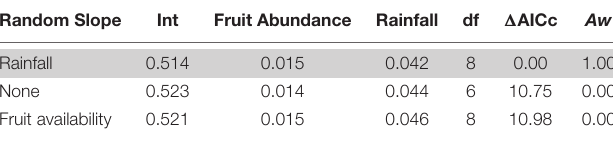
Values = the effect size of standardized continuous predictors included in the model. See Table 1 for the full heading descriptions. ’Gray shading’ = models included in the top model